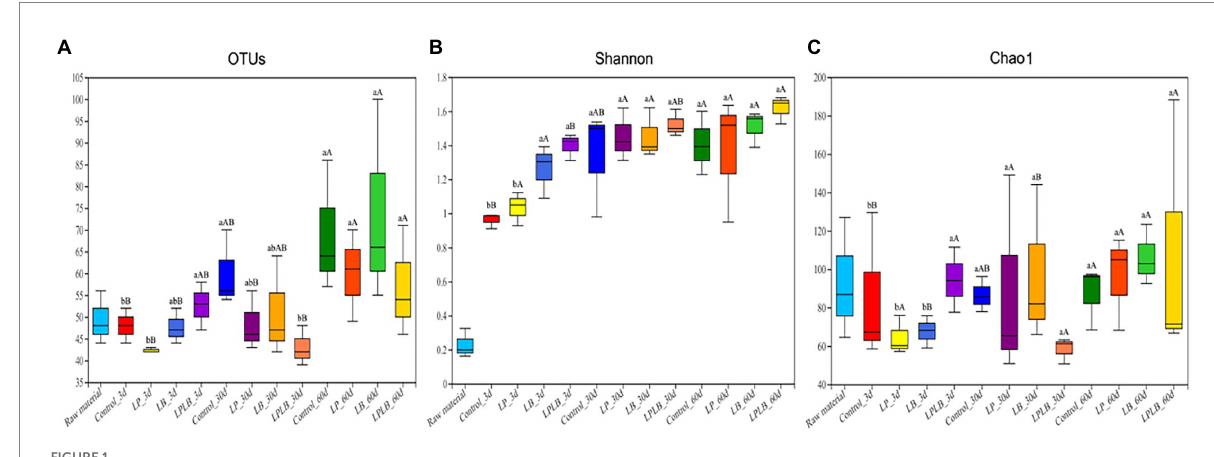
FIGURE 1 Box-plots of observed bacterial species (A) , Shannon (B), and Chao1 indices (C) of bacterial communities in paper mulberry silage. Control, ensiling with no inoculant applied; LP, inoculated with Lactiplantibacillus plantarum ; LB, inoculated with Lactiplantibacillus brevis ; LPLB, inoculated with L. plantarum and L. brevis . OTUs, observed bacterial species. Different lowercase letters indicate significant differences ( p < 0.05) between different treatments at the same time. Different capital letters indicate significant differences ( p < 0.05) between the different time at the same treatment.